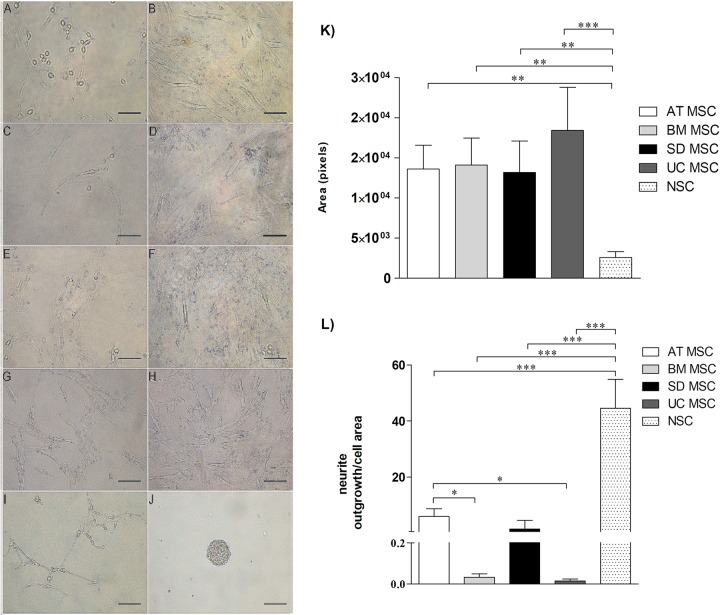
Changes in MSC morphology.Changes in MSC morphology after 18 days of neural differentiation:
(A, B) AT-MSC, (C, D) BM-MSC,
(E, F) SD-MSC, (G, H) UC-MSC,
(I, J) Positive control (NSC). Scale bar 100 μm.
Induced MSC (A, C, E, G) adopt neural-like morphology
as well as cytoplasm retraction towards the nucleus, which is more
notorious in A y E compared to negative controls (B, D, F,
H) and were quantified in (K) Area (pixels)
and (L) Number of cells with visible neurite outgrowth.
Data represents means ± SEM of 3 separate experiments. ns P>
0.05, * P <0.05, ** P <0.01, *** P <0.001.